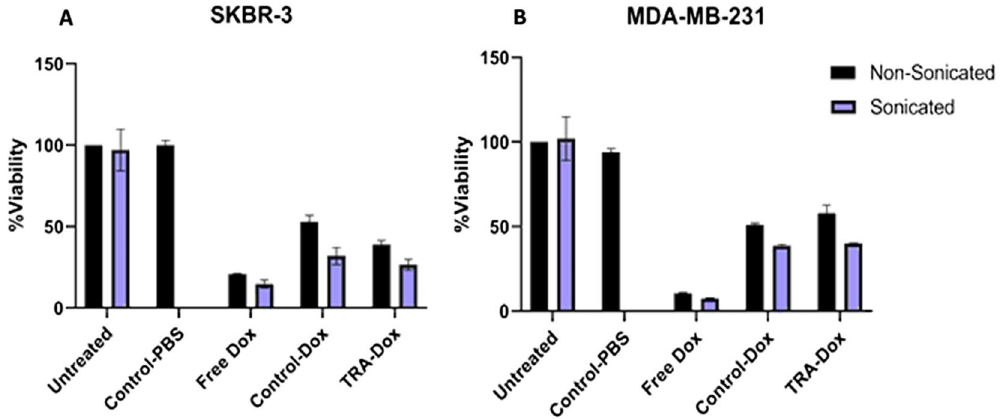
Figure 6. MTT results for (A) SKBR3 cells and (B) MDA-MB-231 cells treated with free DOX, Control- DOX liposomes and TRA-DOX liposomes (DOX concentration: 8 μM) in the absence and presence of LFUS exposure. Sonicated cells were exposed to continuous LFUS in a 35-kHz water bath for 5 min. Data are representative of three independent experiments (mean ± SD %, n =